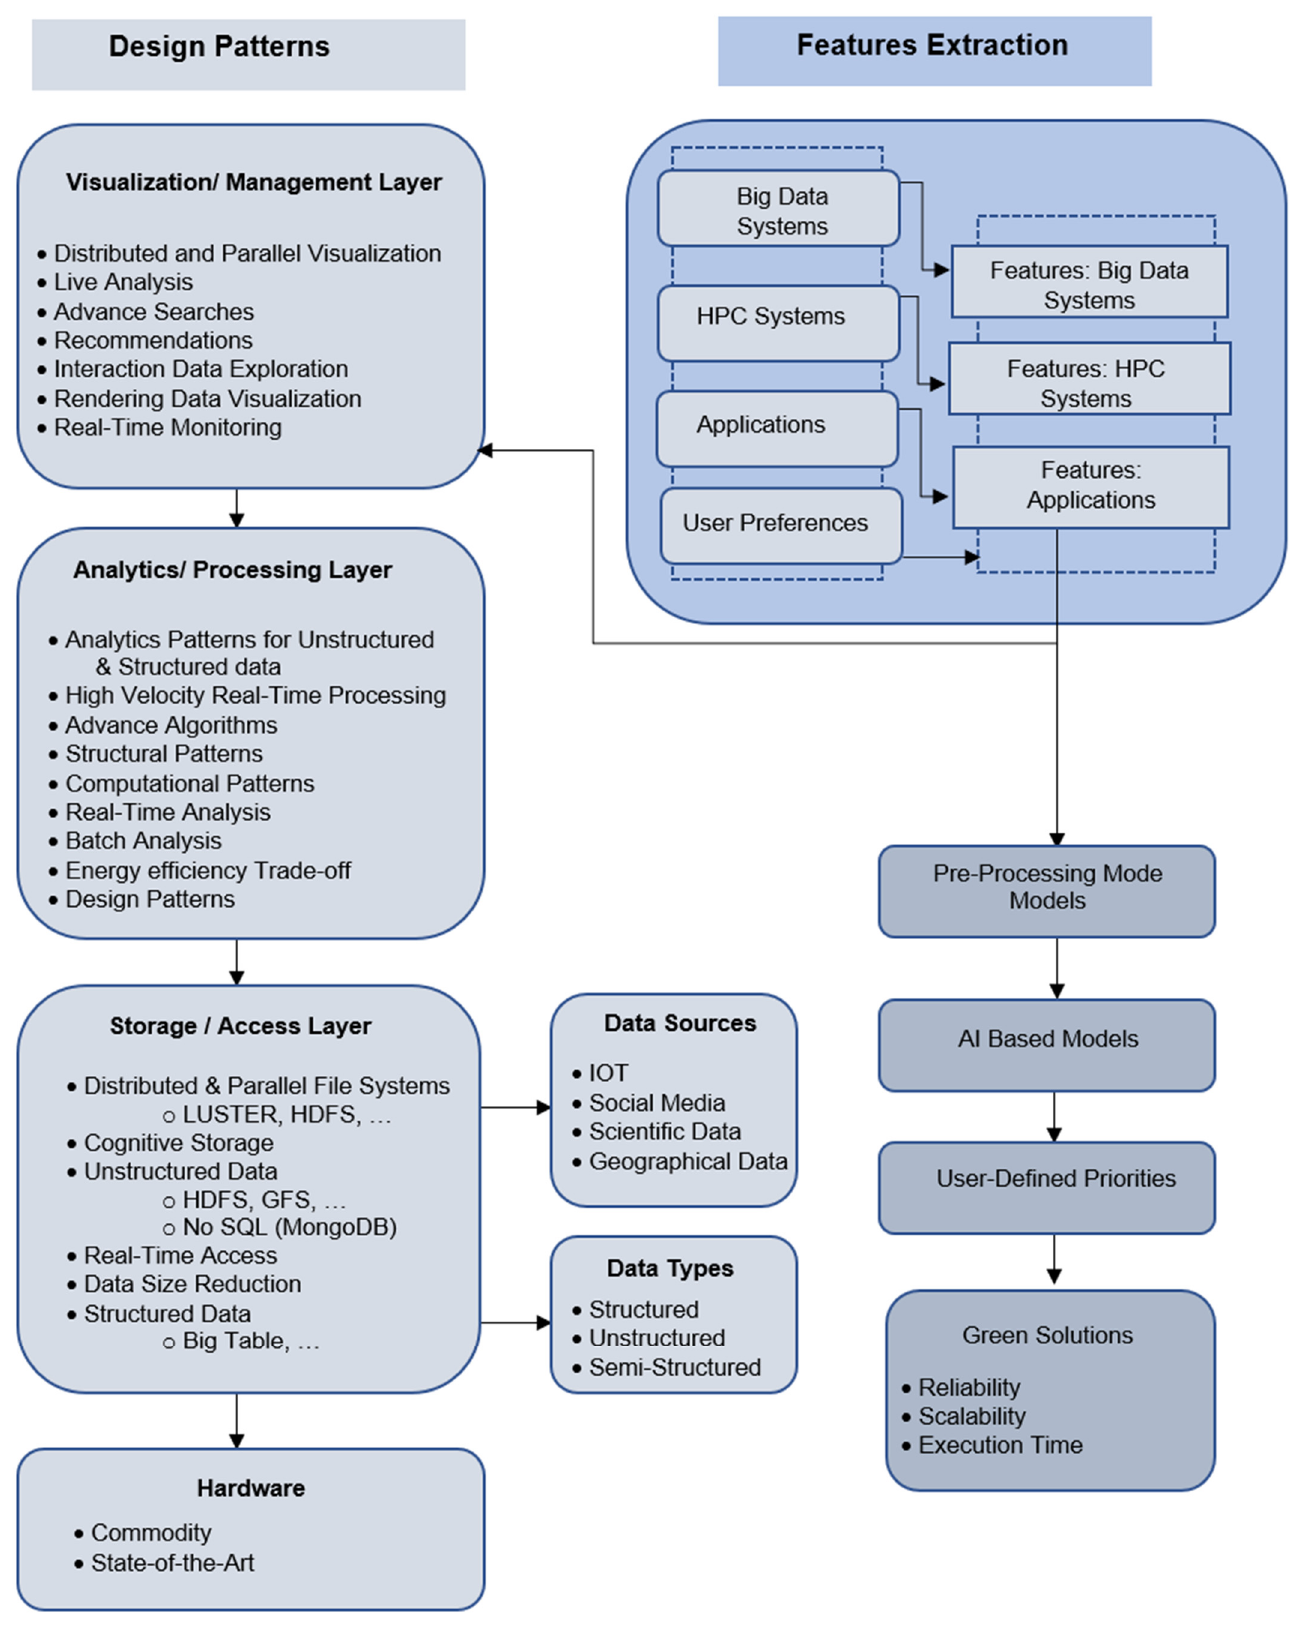
Figure 1. Design patterns and AI-based Architecture for Converged HPC and Big Data Environ- ments.